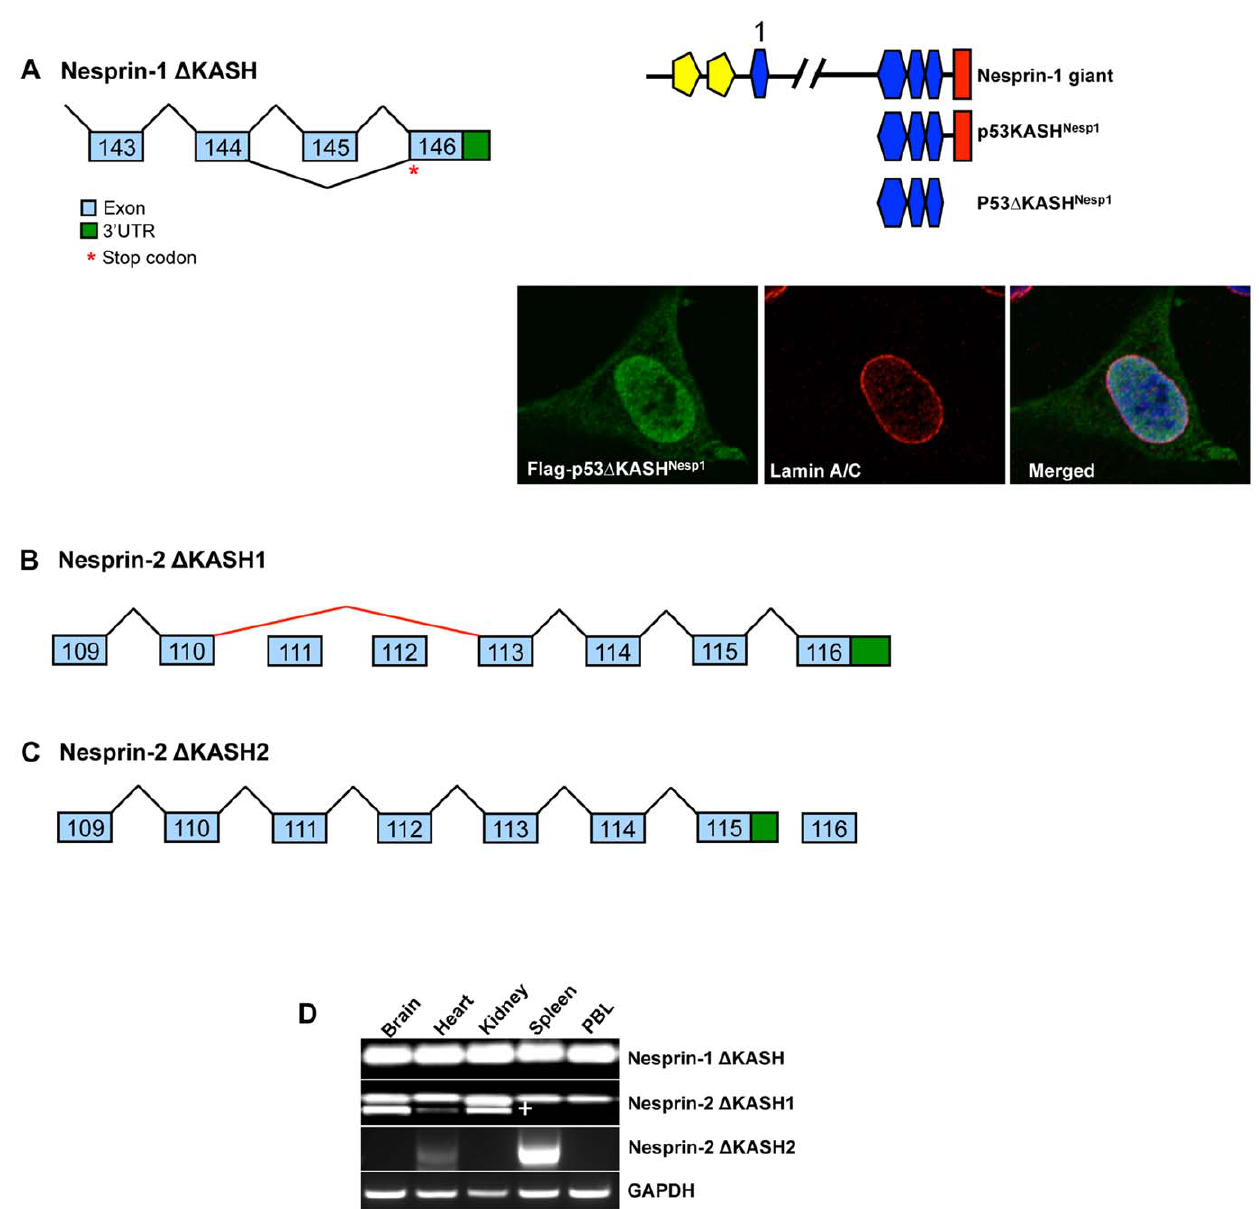
Figure 8. Generation of nesprin-1 and nesprin-2 D KASH variants. A) Nesprin-1 D KASH is generated through the removal of cassette exon 145, resulting in disruption of the KASH domain. Ectopically expressed p53 D KASH Nesp1 fails to localize to the NE in U2OS cells and is strongly concentrated within the nucleus and weakly in the cytosol. B) Nesprin-2 D KASH1 is generated though the removal of exons 111–112 through the splicing event described in the previous section (splicing shown in red). C) Nesprin-2 D KASH2 is generated through utilization of an alternative 3 9 UTR juxtaposed to exon 115. D) PCR-based tissue screen for D KASH variants shows that the removal of exon 145 for Nesprin-1 D KASH is detected in a wide array of tissues. Nesprin-2 D KASH1 splicing is detected pre-dominantly in the brain and kidney with small amounts also detected in the heart. + denotes the spliced Nesprin-2 D KASH1 product. Nesprin-2 D KASH2 was detected in the heart and spleen only. Peripheral Blood Leukocytes (PBL).